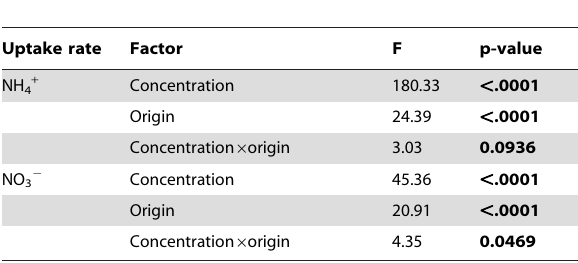
Table 2. Accession effect: linear models of data presented in Fig.